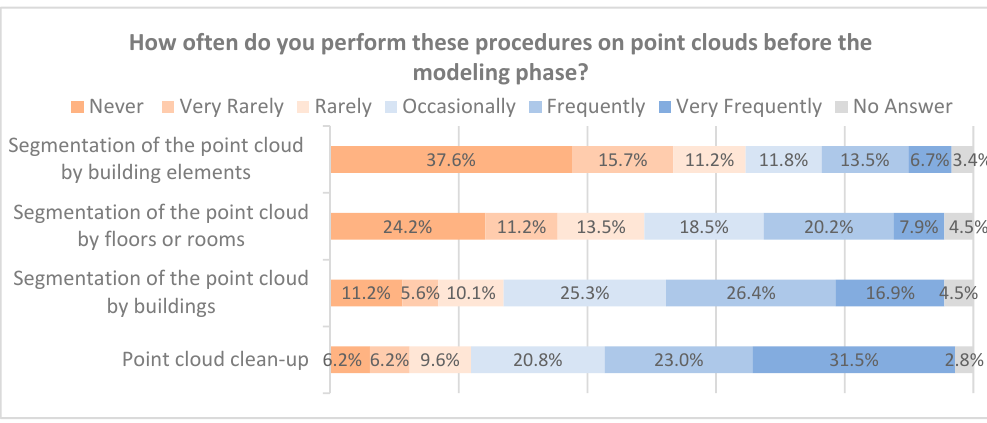
Figure 13. Frequency of procedures performed on point clouds before the modeling phase.